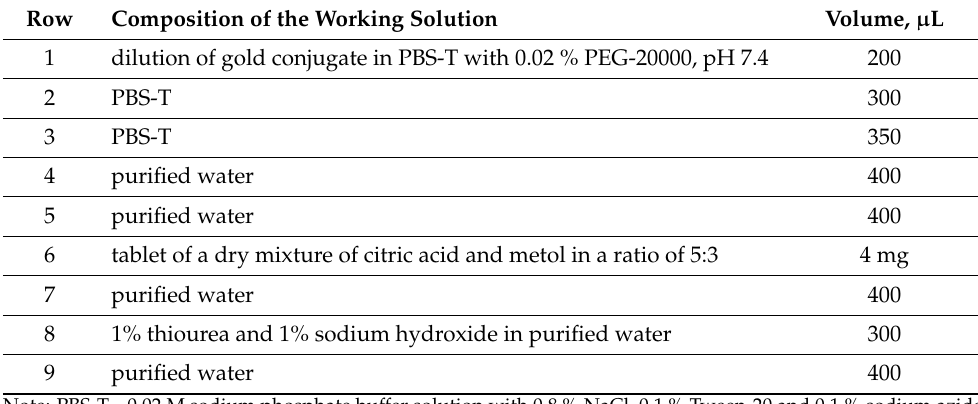
Table 1. Analytical bath wells content.